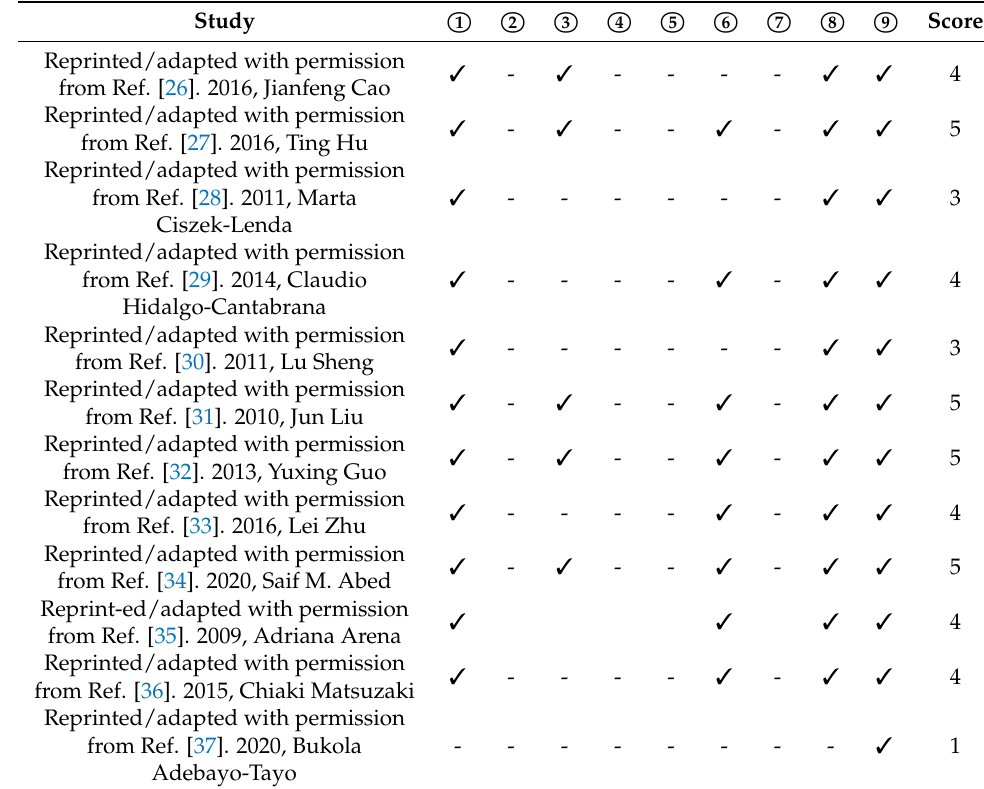
Table 3. Quality assessment analysis